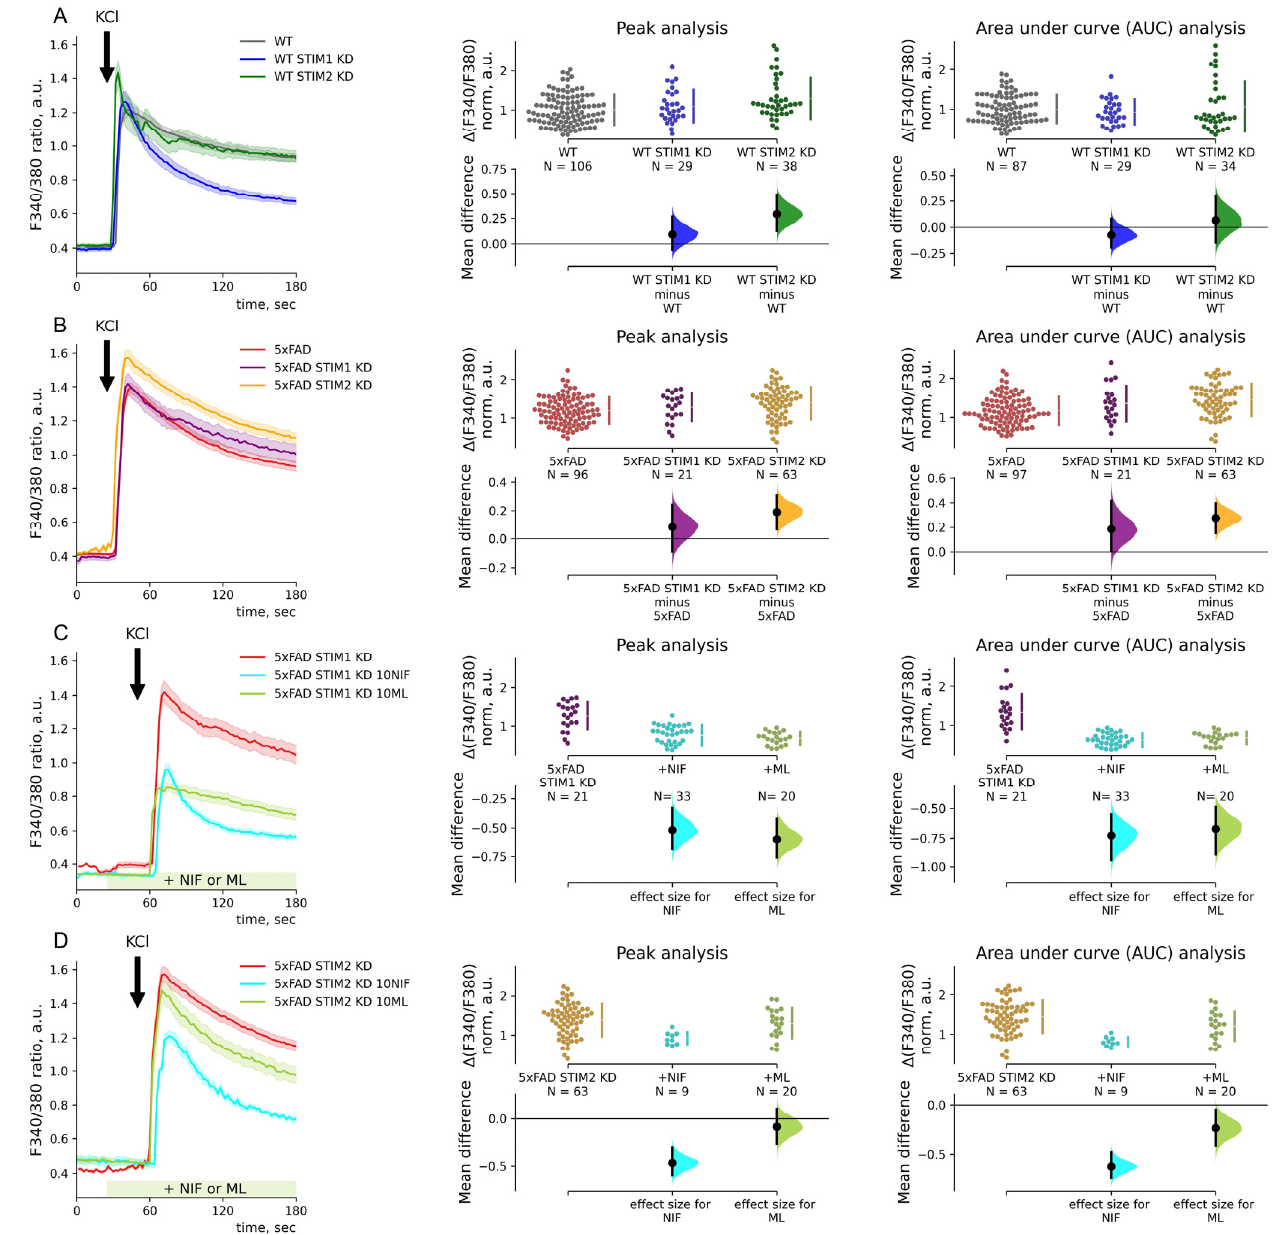
Figure 5. In hippocampal neurons, voltage-gated calcium entry is regulated by STIM2 sensors. ( A – D ) Calcium imaging with Fura2 of neurons of primary hippocampal cultures of wild-type (WT, gray) and 5xFAD mice and treated with STIM1/STIM2 shRNA lentiviruses (STIM1 KD and STIM2 KD) or mock shRNA lentivirus. Inhibitory analysis has been performed with 10 μ M nifedipine (NIF), an inhibitor of L-type calcium channels, and 10 μ M ML218 (ML), an inhibitor of T-type calcium channels. The inhibitors were introduced 1 min before KCl application. Mean traces of F340/380 ratio are represented as mean ± SEM. 50 mM KCl (KCl) was added to induce calcium entry. Calcium entry ( Δ F340/F380) was calculated as the F340/F380 peak of each trace after KCl application, and the baseline was subtracted. Areas under the curve (AUC) were calculated for 40 sec after KCl applications. Δ F340/F380 and AUC data are normalized by the mean WT neuron values and shown in separate estimation plots. The estimation plots have normalized Δ F340/F380 data plotted on the upper axes and mean differences plotted on floating axes on the bottom as bootstrap sampling distributions. (A) The Kruskal–Wallis ANOVA ( p < 0.01 for peaks and AUC values) with post hoc Dunn’s test was implemented; pairwise p -values were calculated for WT values comparison. Mean differences between KCl-induced calcium entry in WT and WT STIM1 KD or WT STIM2 KD neurons are 0.09 and 0.29 with p = 0.91 and 0.005 for amplitudes and − 0.07 and 0.06 with